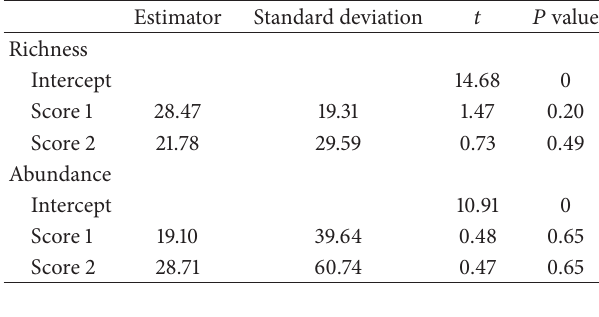
Figure5:ResultsoftheNMDSanalysisofthenumberofindividuals per guild recorded in each control (AC1, AC2, AC3, and AC4) and burned plot (AF1, AF2, AF3, and AF4) in the study area in eastern Acre, Brazil, based on the Bray-Curtis index.